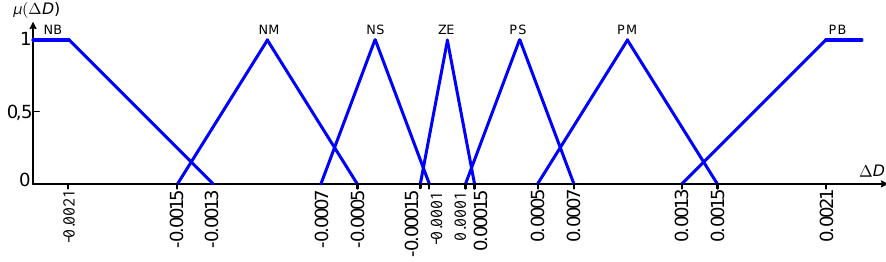
Figure 11. Membership functions for output variable ∆ D